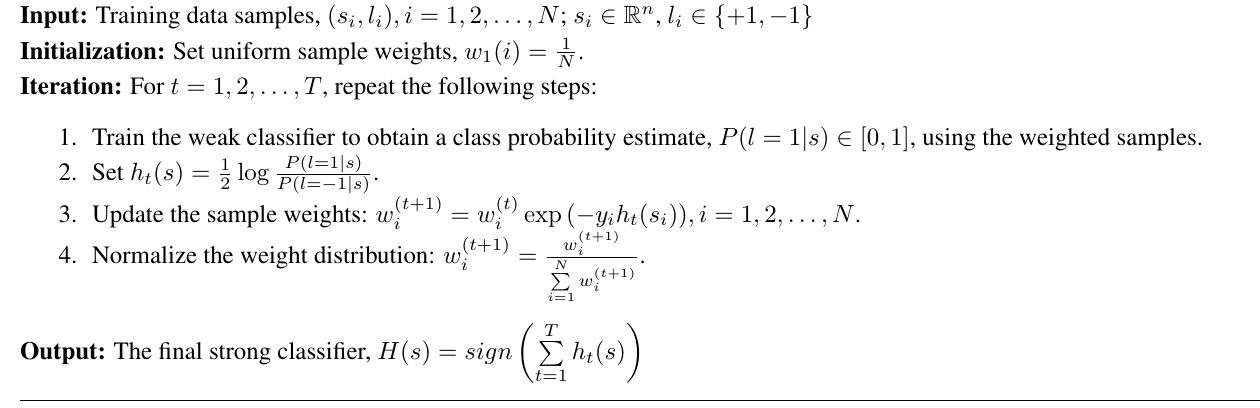
Algorithm 1 Outline of Real